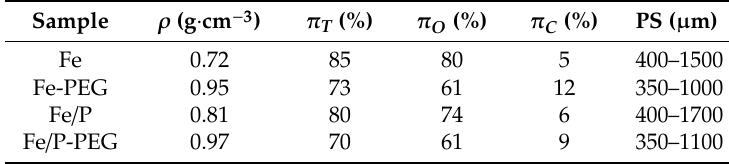
Table 1. Density ( ρ ), total ( π T ), open ( π O ) and closed porosity ( π C ), and pore size (PS) of iron-based foams.